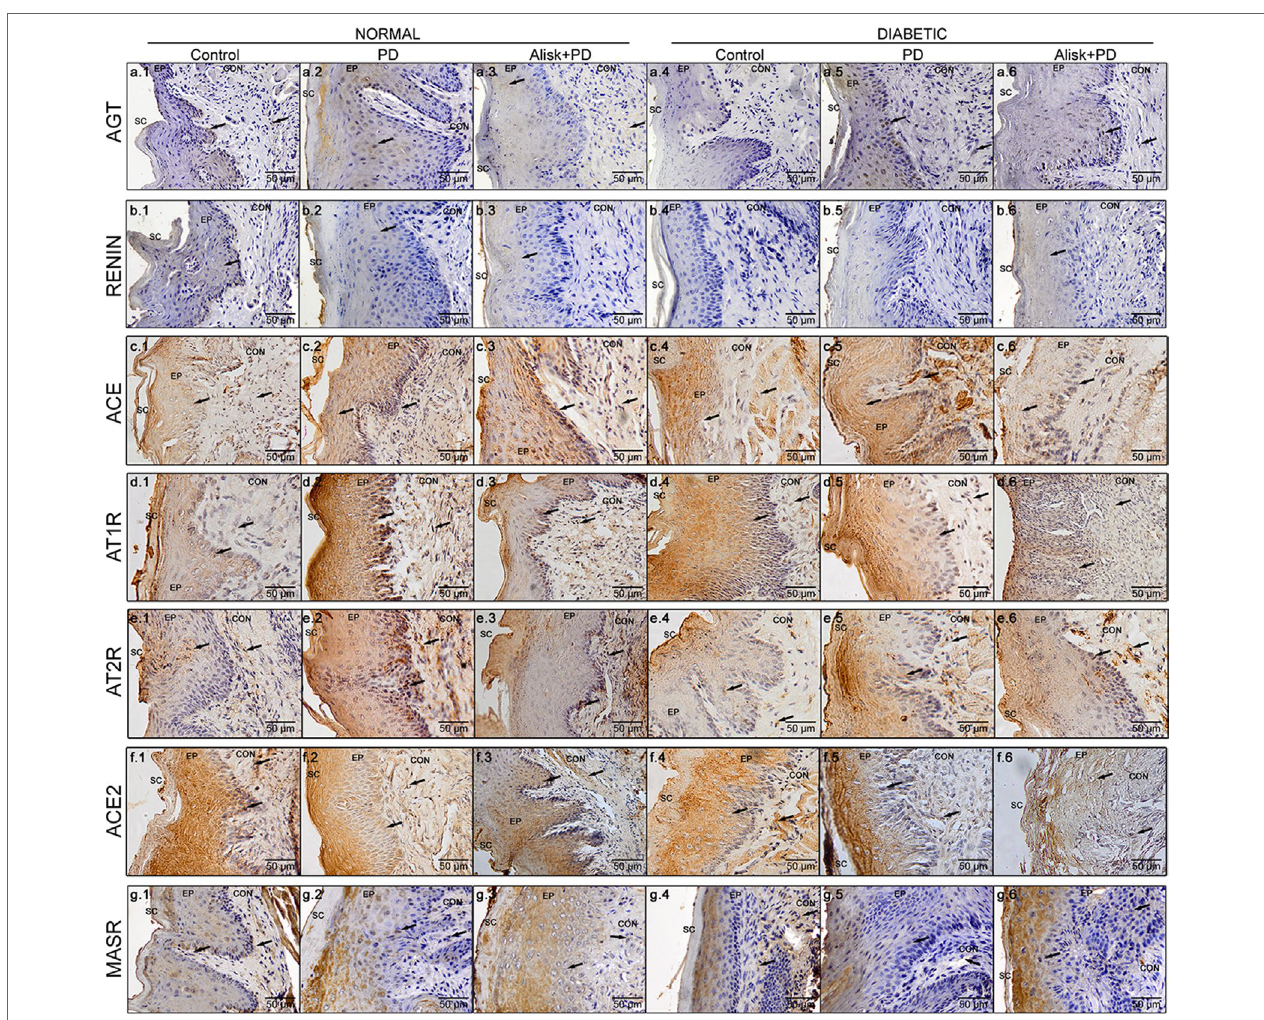
FIGURE 4 | Immunoreactivity for AGT, renin, ACE, AT1R, AT2R, ACE2, and MasR in gingival tissue of normal and diabetic mice 14 days after PD. AGT production of normal mice (a.1 control, a.2 with PD, and a.3 with Alisk + PD) and diabetic mice (a.4 control, a.5 with PD, and a.6 with Alisk + PD); Renin production of normal mice (b.1 control, b.2 with PD, and b.3 with Alisk +PD), and diabetic mice (b.4 control, b.5 with PD, and b.6 with Alisk+PD); ACE production of normal mice (c.1 control, c.2 with PD, and c.3 with Alisk + PD), and diabetic mice (c.4 control, c.5 with PD, and c.6 with Alisk + PD); AT1R production of normal mice (d.1 control, d.2 with PD, and d.3 with Alisk +PD), and diabetic mice (d.4 control, d.5 with PD, and d.6 with Alisk+PD); AT2R production of normal mice (e.1 control, e.2 with PD, and e.3 with Alisk + PD), and diabetic mice (e.4 control, e.5 with PD, and e.6 with Alisk + PD); ACE2 production of normal mice (f.1 control, f.2 with PD, and f.3 with Alisk +PD), and diabetic mice (f.4 control, f.5 with PD, and f.6 with Alisk+PD); MasR production of normal mice (g.1 control, g.2 with PD, and g.3 with Alisk +PD), and diabetic mice (g.4 control, g.5 with PD, and g.6 with Alisk+PD). All images are at 20× magnification, and scale bars indicate a distance of 50 µm. Brow staining indicates positive IR. Abbreviations: sc, superficial cells; ep, epithelium; BL, basal cell layer; LP, lamina